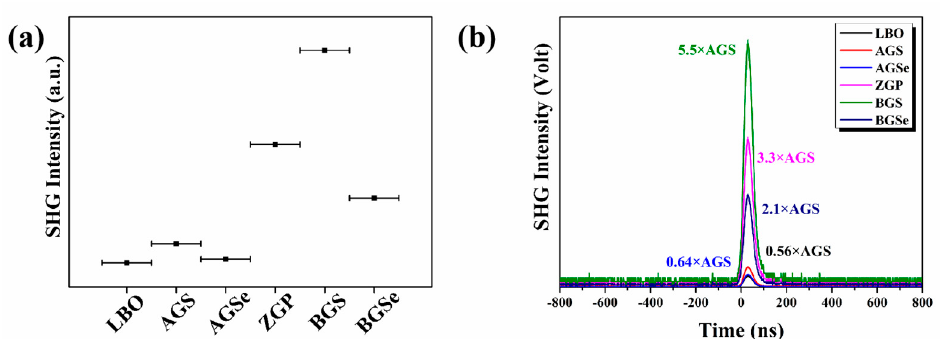
Figure 1. ( a ) The SHG intensities of LBO, AGQ (Q = S, Se), ZGP, and BGQ (Q = S, Se) samples at particle sizes of 20 − 50 µ m; ( b ) oscilloscope traces of SHG signals for LBO, AGQ (Q = S, Se), ZGP, and BGQ (Q = S, Se) samples (AGS as a reference). Table 2. Powder SHG intensity and the calculated SHG coe ffi cient from di ff erent reference materi- als.